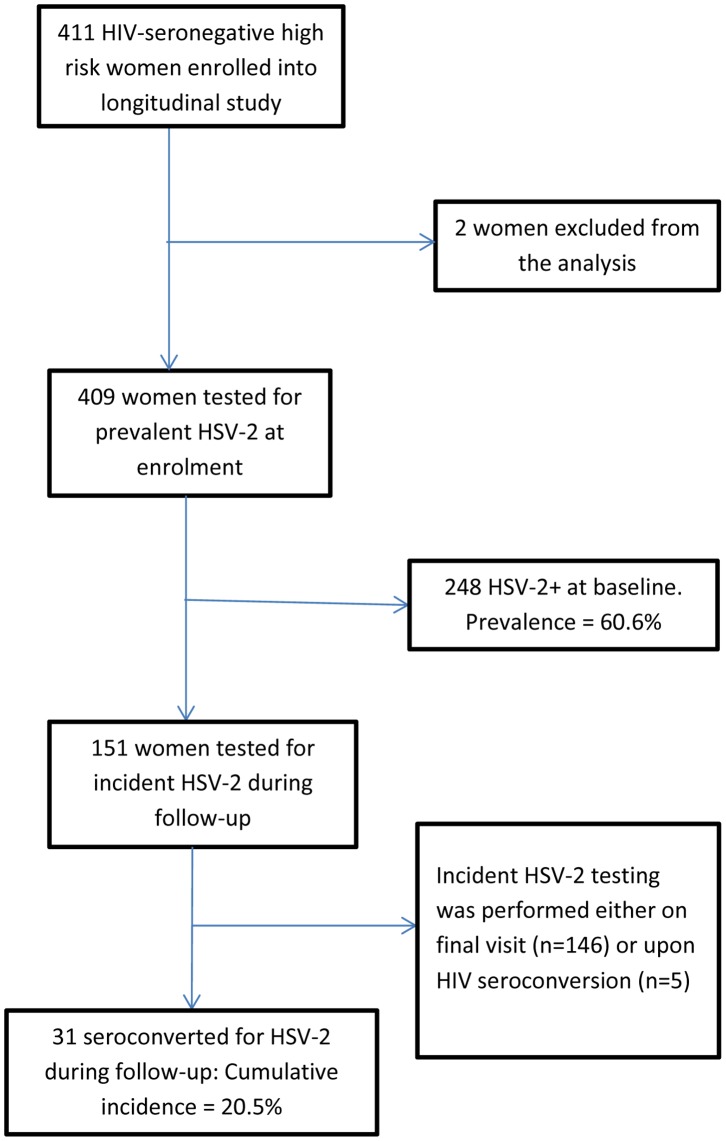
Participant flow diagram describing numbers enrolled, numbers tested for HSV-2 prevalence, and numbers included for HSV-2 incidence.